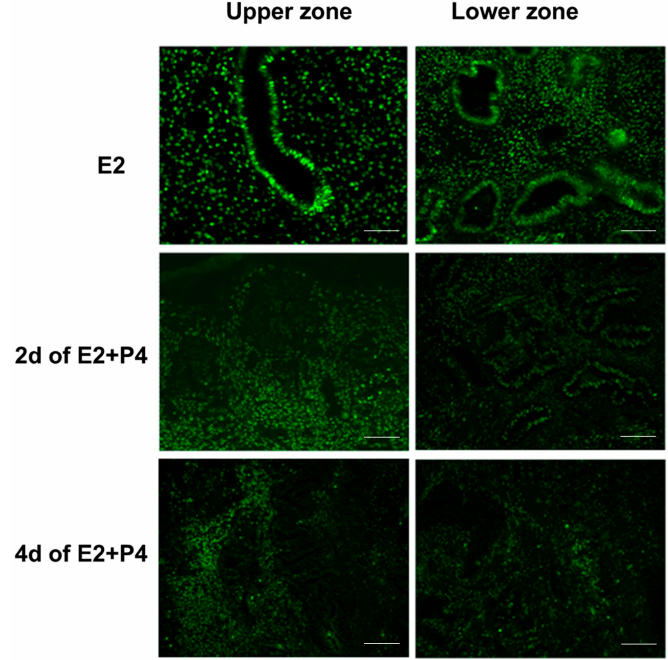
Figure 6. PR expression in the upper and lower zones of full thickness endometrial slices in culture. Compared to ER, more dramatic decrease in PR expression in both glands and stromal cells after P4 treatment. Scale bar 200 µ m; Original magnification 160 ×